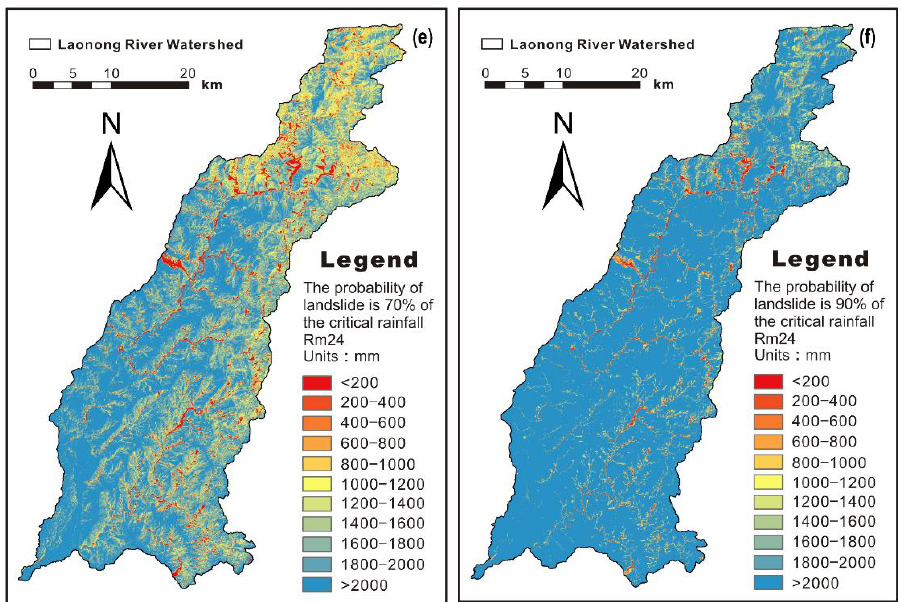
Figure 7. Simulation results of landslide probability due to rainfall and critical rainfall derived from the 2005 model. ( a ) rainfall of 300 mm, ( b ) rainfall of 600 mm, ( c ) rainfall of 900 mm, ( d ) landslide probability of 50%, ( e ) landslide probability of 70%, ( f )landslide probability of 90%. Remote Sens. 2020 , 12 , x FOR PEER REVIEW